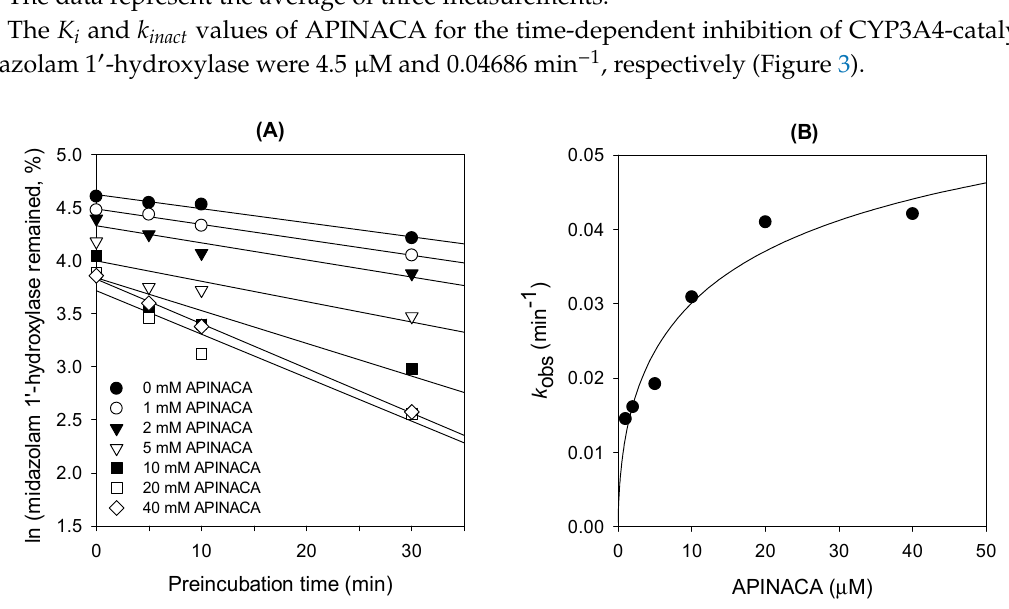
Figure 3. ( A ) Inactivation kinetics of 1 ′ -hydroxymidazolam formation from midazolam in ultrapooled human liver microsomes using various concentrations of APINACA and ( B ) the relationship between the k obs values and the APINACA concentrations to determine the K i and k inact values for the time-dependent inhibition of CYP3A4-mediated midazolam 1 ′ -hydroxylation. APINACA moderately inhibited UGT1A9-catalyzed mycophenolic acid glucuronidation with an IC 50 value of 32.7 µ M but negligibly inhibited UGT1A1-catalyzed SN-38 glucuronidation, UGT1A3-catalyzed chenodeoxycholic acid 24-acyl- β -glucuronidation, UGT1A4-catalyzed trifluoperazine N -glucuronidation, UGT1A6-catalyzed N -acetylserotonin glucuronidation, and UGT2B7-catalyzed naloxone 3- β - d -glucuronidation in human liver microsomes at 100 µ M with and without 30 min preincubation (Figure 4). The inhibitory potentials of UGT inhibitors were also evaluated in ultrapooled humanlivermicrosomes: atazanavir(IC 50 , 0.7 µ M),glycyrrheticacid(IC 50 , 4.2 µ M),efavirenz(IC 50 ,2.0 µ M), troglitazone (IC 50 , 6.0 µ M), magnolol (IC 50 , 9.7 µ M), and diclofenac (IC 50 , 29.4 µ M) inhibited UGT1A1, UGT1A3, UGT1A4, UGT1A6, UGT1A9, and UGT2B7,